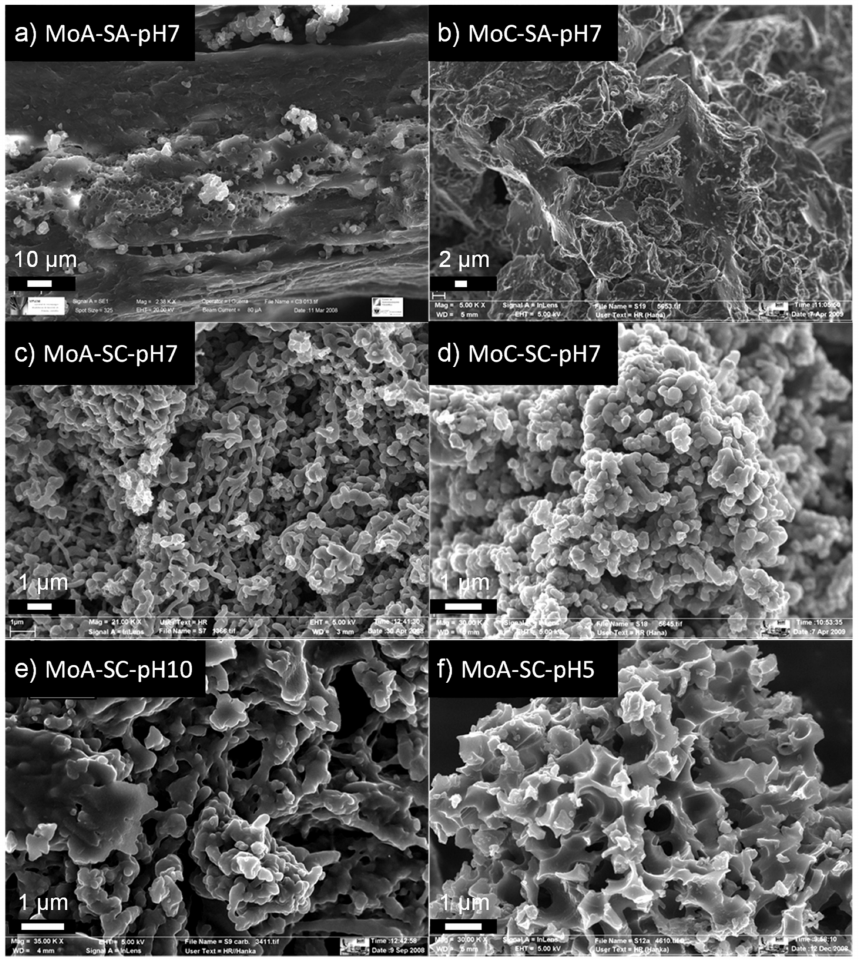
Figure 3. SEM images of Mo-doped carbon xerogels.